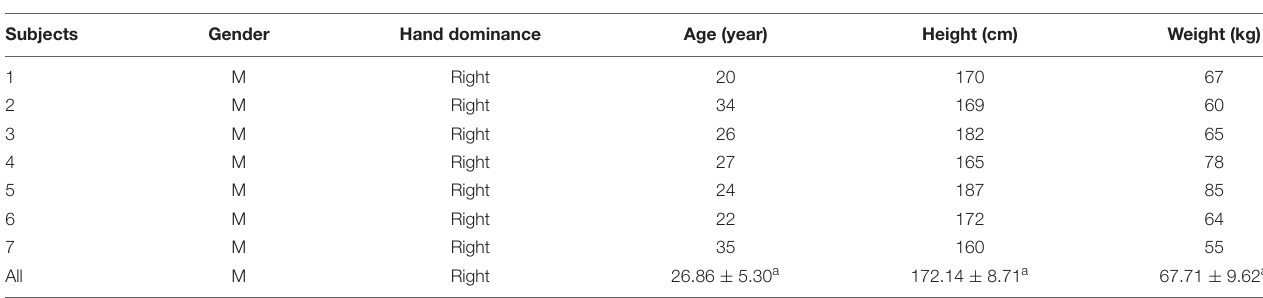
TABLE 1 | Characteristics of the subjects ( N =